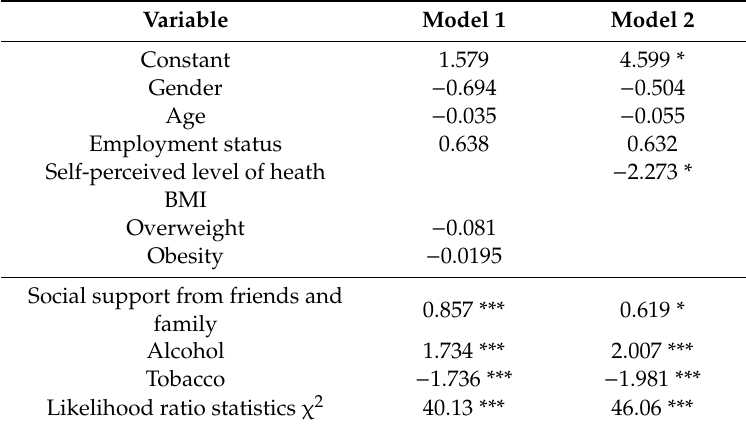
Table 2. Results of logit regression of LTPA.